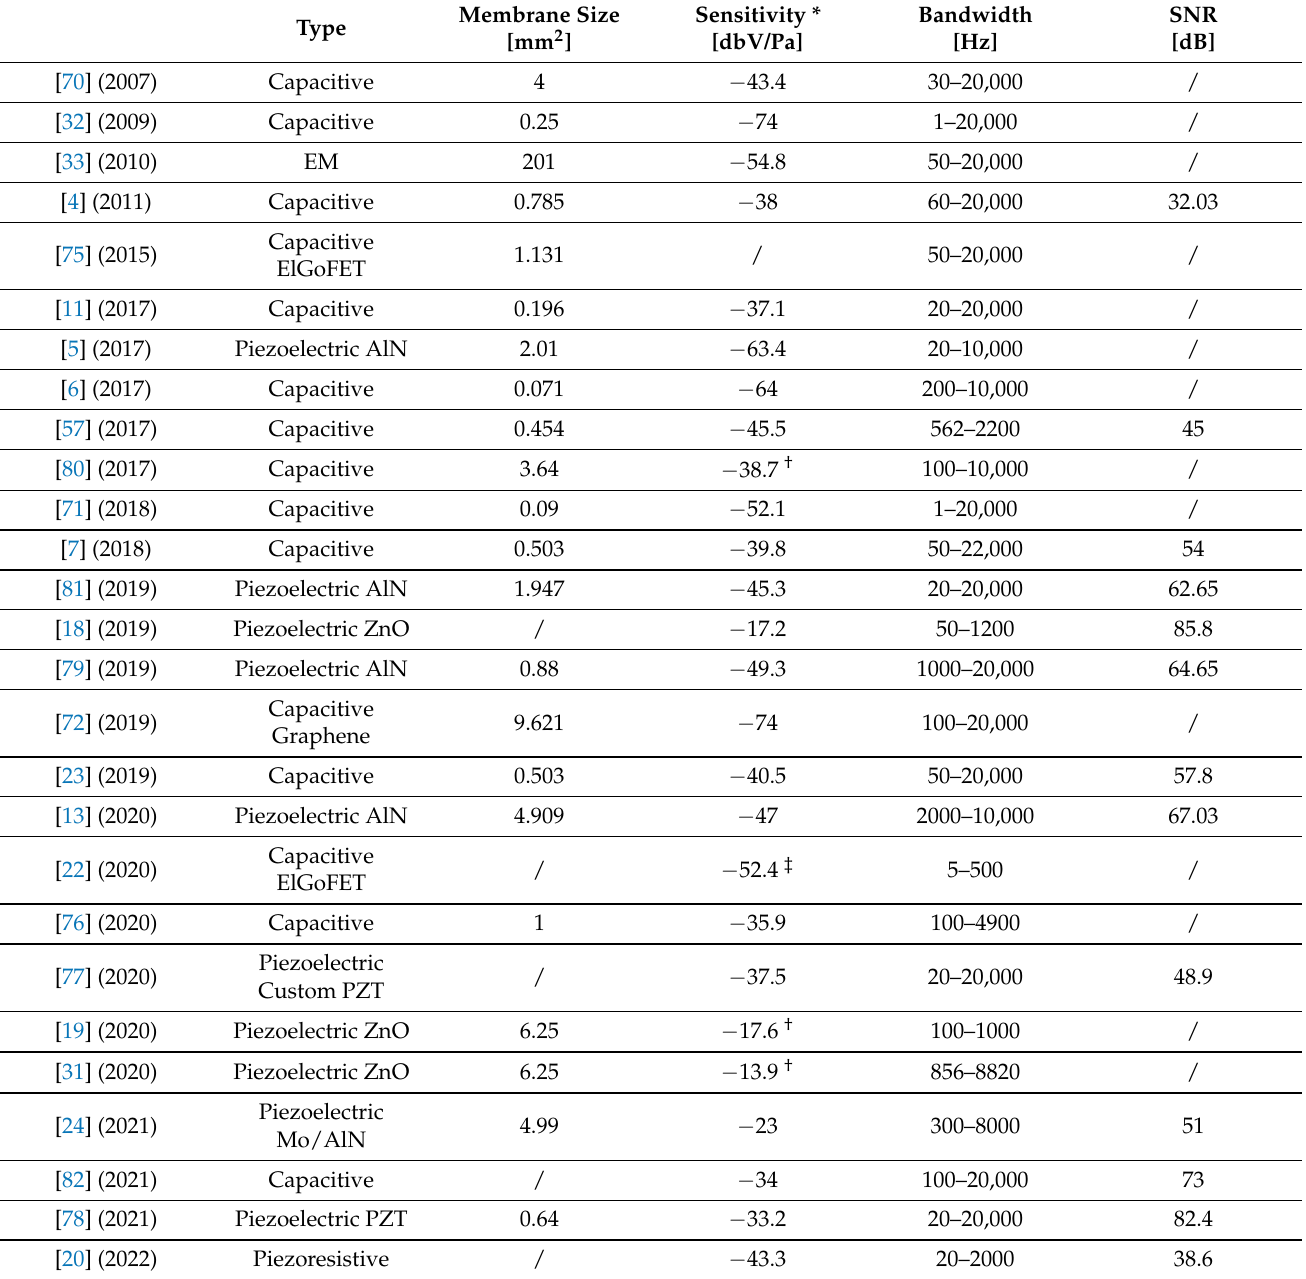
Table 1. Summary of state-of-the-art MEMS